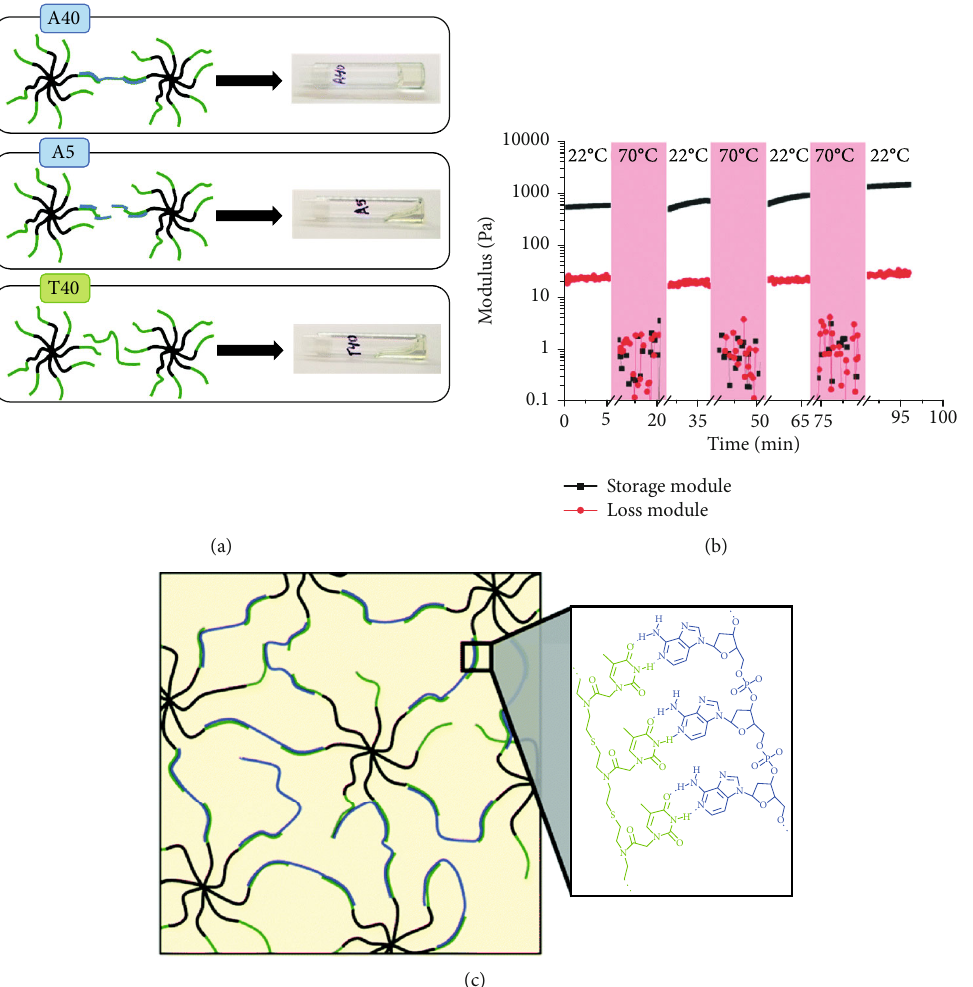
Figure 6: (a) Schematic of the “ click ” nucleic acids used for an 8PEG-thymine macromer crosslinking using a 40-mer adenine ssDNA, a 5- mer ssDNA adenine, and a 40-mer thymine ssDNA. It was observed that the hydrogel would crosslink only in the presence of long thymine- complementary strands. (b) When subjected to a denaturalizing temperature, the sti ff ness of the hydrogel decreased considerably. However, this mechanism appears to be reversible, as the mechanic properties of the material change accordingly to the input temperature. (c) As the 40-mer adenine ssDNA will anneal with the thymine strands, the crosslinker could potentially bind with multiple 8PEG-T oligomers. These fi gures have been reproduced with permission from the American Chemical Society